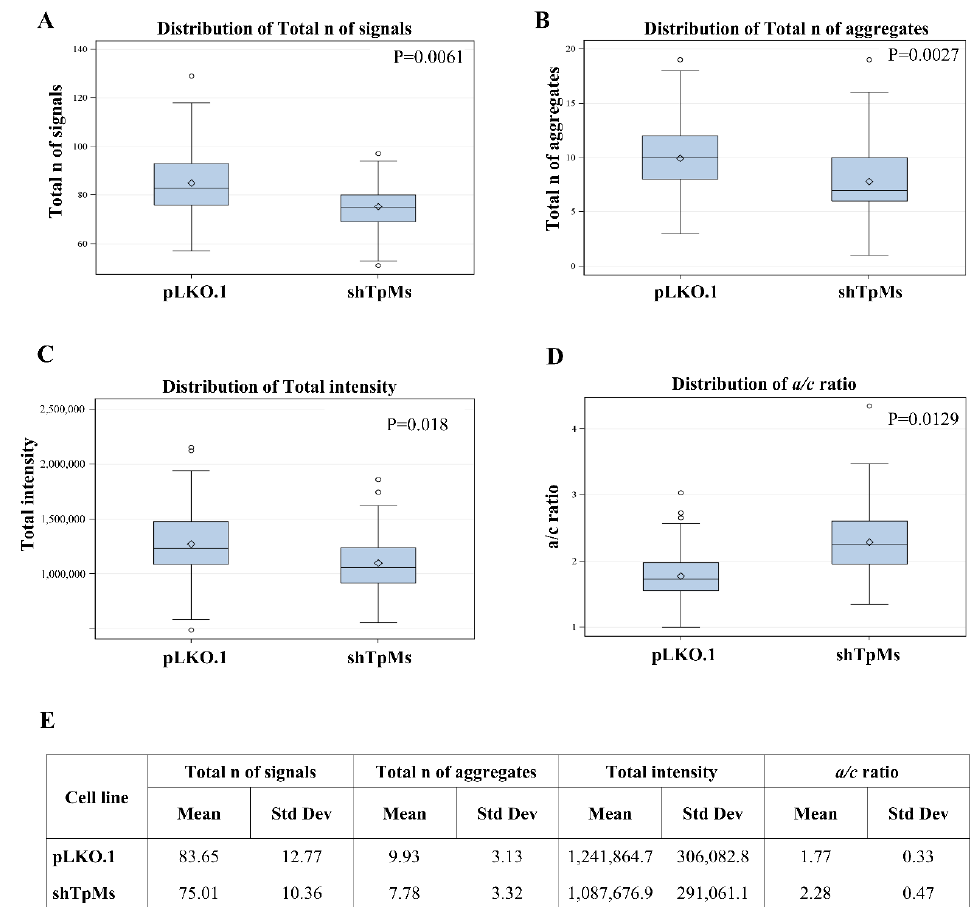
Figure 1. Loss of TpMs induces telomere dysfunction. Analysis of 3D nuclear telomere using TeloView in TpMs-depleted HCT116 cells shows a decrease in distribution of the total number of signals ( p = 0.0061) ( A ); distribution of total numbers of aggregates ( p = 0.0027) ( B ); distribution of total Intensity ( p = 0.018) ( C ), and increase in distribution of a/c ratio ( p = 0.0129) ( D ) compared with control cells (pLKO.1). The a/c ratio is defined as the nuclear space occupied by telomeres, represented by three axes of length a, b and c. The ratio between the a and c axes, the a/c ratio, reflects the distribution of telomeres, which changes at different stages of the cell cycle. ( E ) Mean = average of three different experiments. Std Dev = standard deviation.